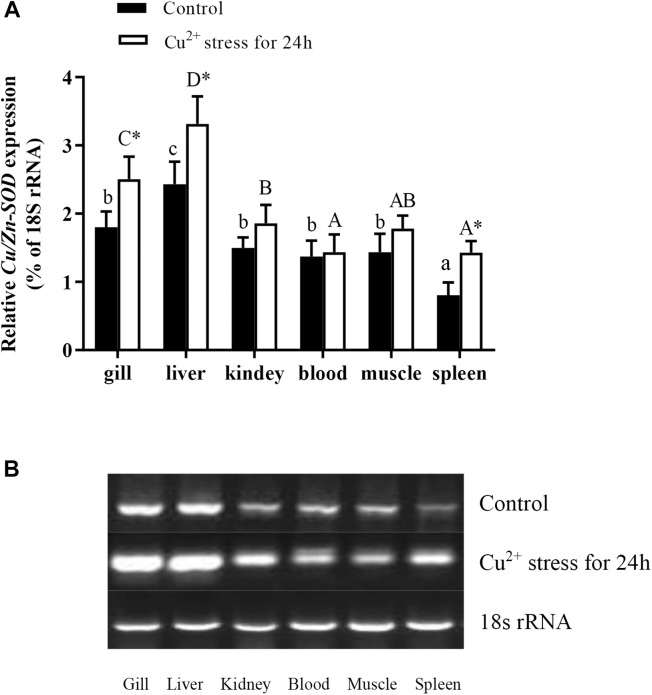
Expression analysis of Cu/Zn-SOD gene in different tissues of healthy hybrid yellow catfish (Pelteobagrus fulvidraco♀ × P. vachelli♂) (control) or yellow catfish subjected to 140 μg⋅L-1 Cu2+ stress for 24 h. (A) Expression levels of Cu/Zn-SOD in different tissues of control group or 140 μg⋅L-1 Cu2+-stressed group for 24 h as determined by qRT-PCR. Different lowercase letters indicate significant differences among different tissues in control group (P < 0.05, Duncan’s multiple comparison). Different uppercase letters indicate significant differences among different tissues in 140 μg⋅L-1 Cu2+-stressed group at 24 h (P < 0.05, Duncan’s multiple comparison). ∗ indicates significant differences between control group and 140 μg⋅L-1 Cu2+-stressed group (P < 0.05, independent sample t test). (B) Semi-quantitative results of Cu/Zn-SOD transcript levels in different tissues of control group or 140 μg⋅L-1 Cu2+-stressed group at 24 h as determined by agarose gel electrophoresis analysis.